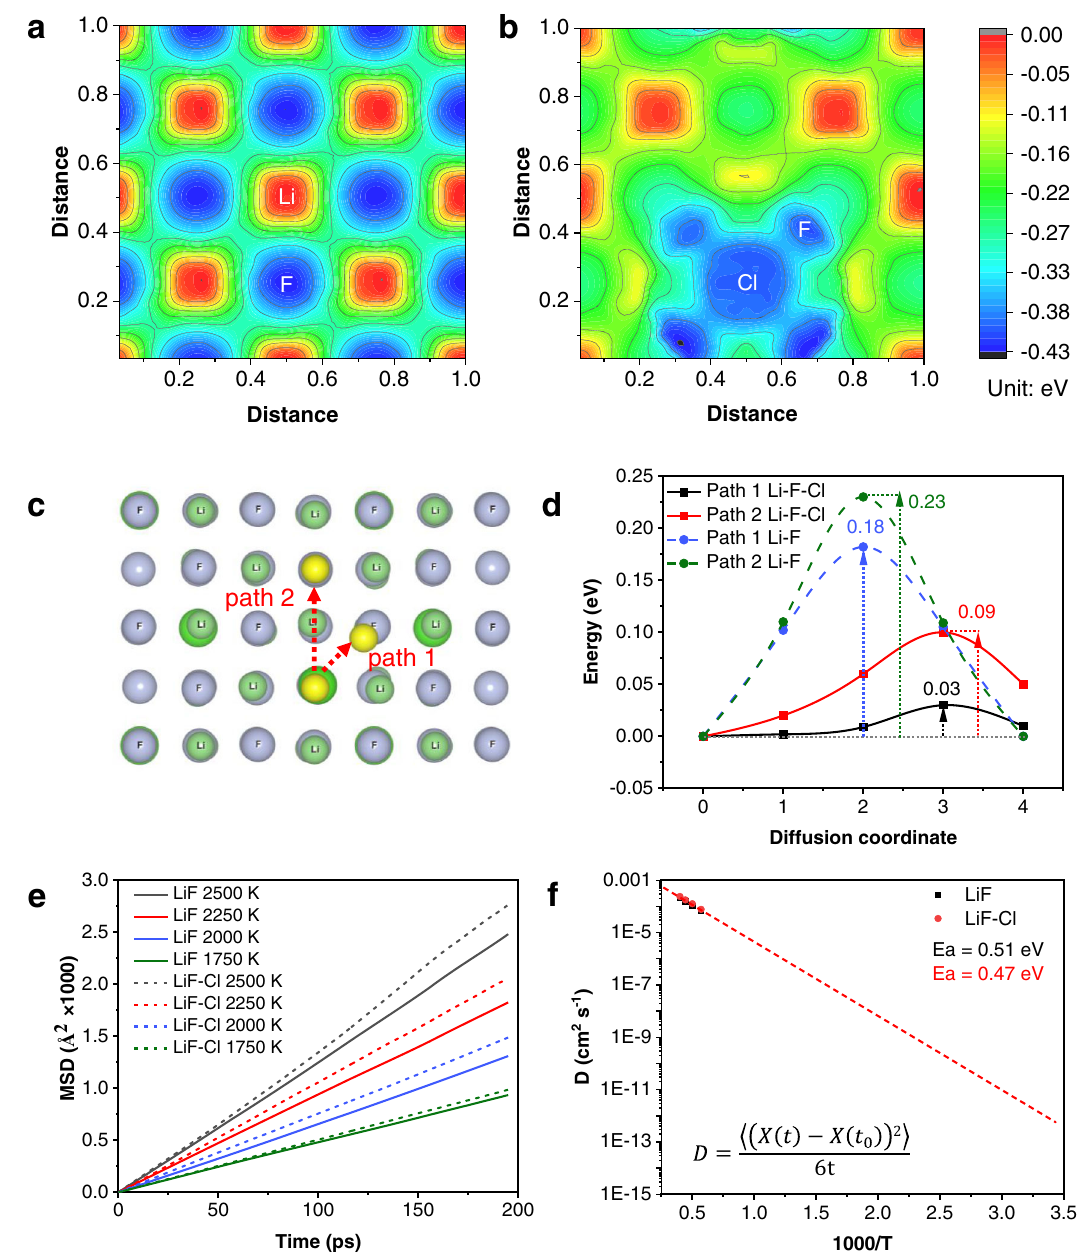
Fig. 4 | Simulation of Li + transfer in SEI. Binding energy landscape for Li + diffusion along a LiF and b LiF 1- x Cl x grain boundaries. c Schematic illustration of Li + diffusion path. d Variation of NEB energies with path 1 and path 2 along LiF or LiF 1- x Cl x grain